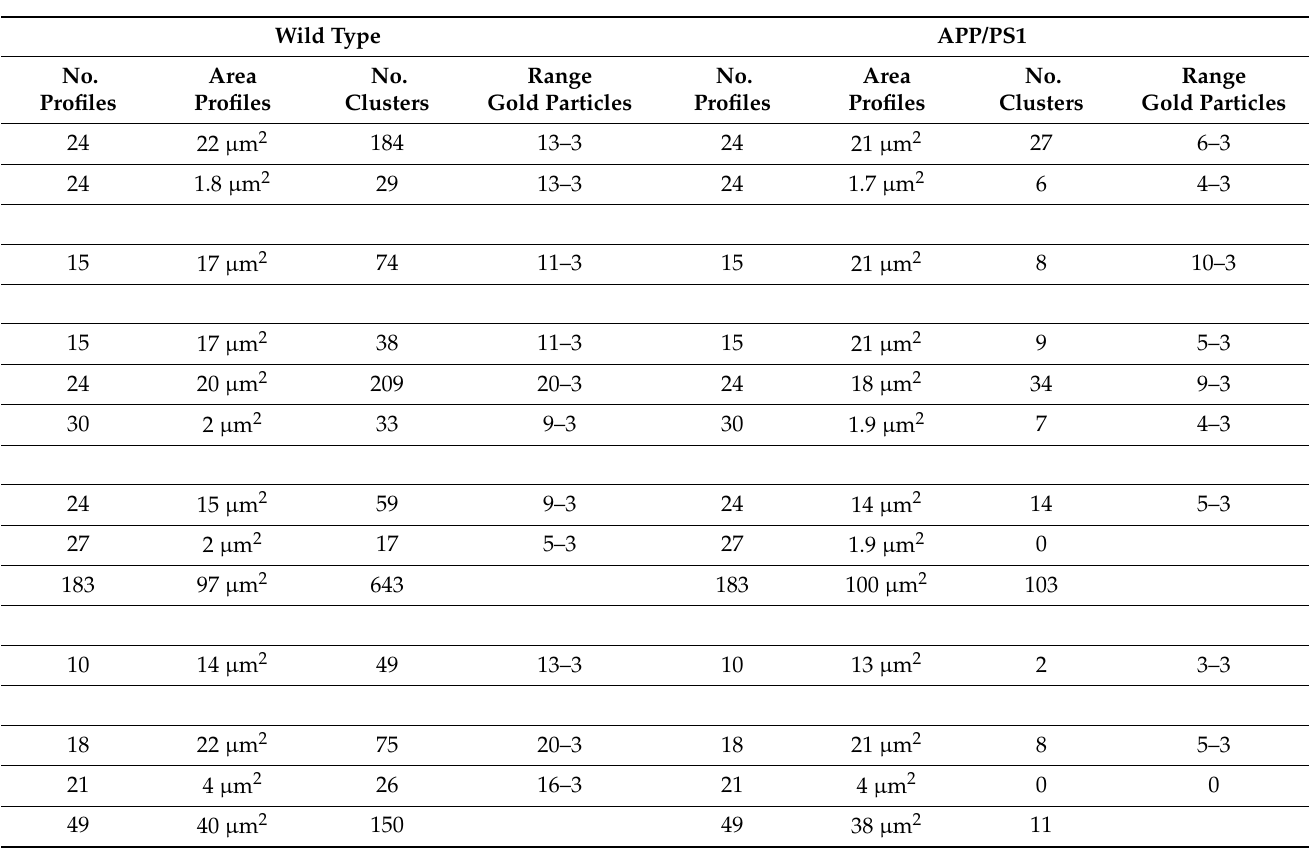
Table 2. Composition of clusters of mGlu 5 immunoparticles along the membrane surface of CA1 pyramidal cells and DG granule cells at 12 months of